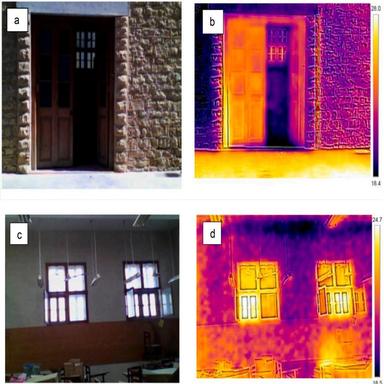
a) Original W9 wall; b) thermal image of W9; c) original inside W13 wall; d) thermal image of W13.